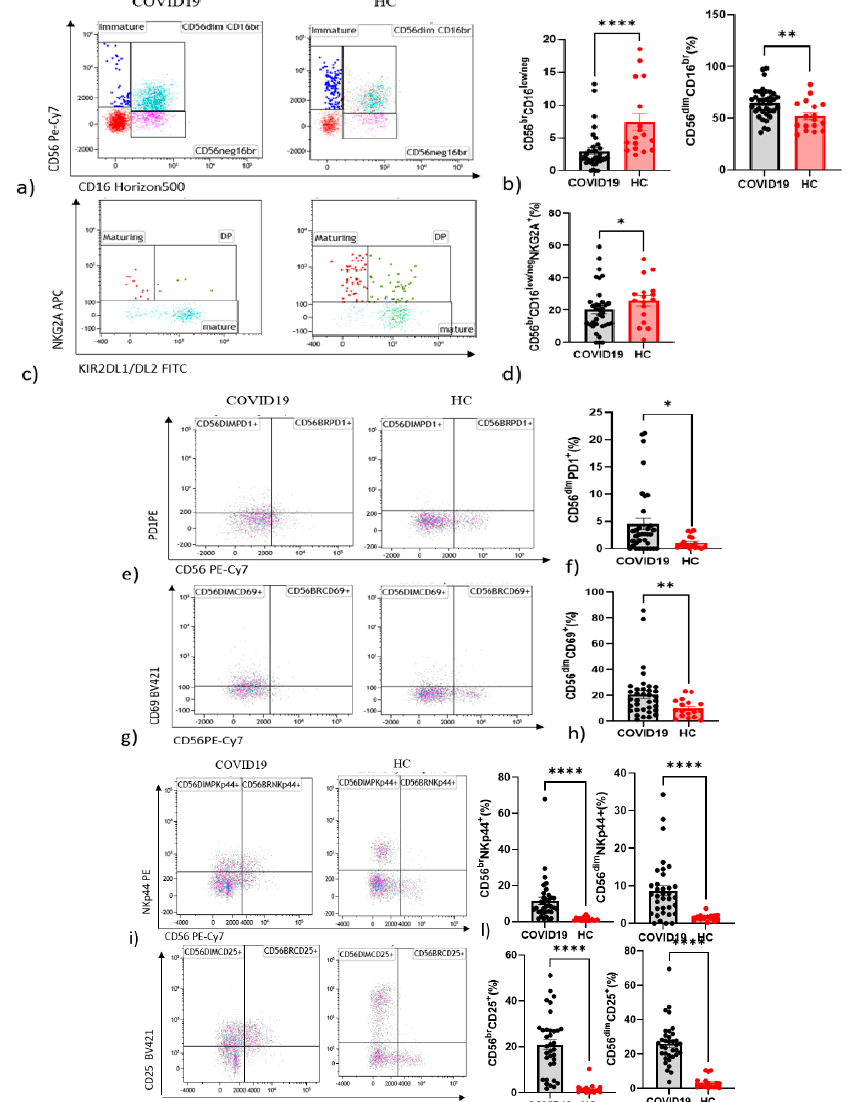
Figure 1. Alteration in the proportion of NK cell subsets expressing in peripheral blood NK cells from COVID-19 patients and HC. ( a ) Frequency of CD56 bright CD16 low Immature NK. CD56 dim CD16 bright Mature NK cell and CD56 neg CD16 bright NK cells subsets among groups. ( b ) Histogram of comparisons of cell expression in NK cells among groups. ( c ) Frequency of NKG2A + KIR - Maturing NKG2A + KIR + DP NK cell and NKG2A - KIR + NK subsets among groups. ( d ) Histogram of compar- isons of cell expression NKG2A and KIR on NK cells among groups. ( e ) Frequency of PD1+NK cell subsets among groups. ( f ) Histogram of comparisons of cell expression in PD1+NK cells among groups. ( g ) Frequency of CD69+NK cell subsets among groups. ( h ) Histogram of comparisons of cell expression in CD69+NK cells among groups. ( i ) Frequency of NKp44 + NK cell subsets among groups. ( l ) Histogram of comparisons of cell expression in NKp44 + NK cells among groups. ( m ) Frequency of CD25 + NK cell subsets among groups. ( n ) Histogram of comparisons of cell expression in CD25 + NK cells among groups. * p < 0.05. ** p < 0.01, **** p < 0.0001.